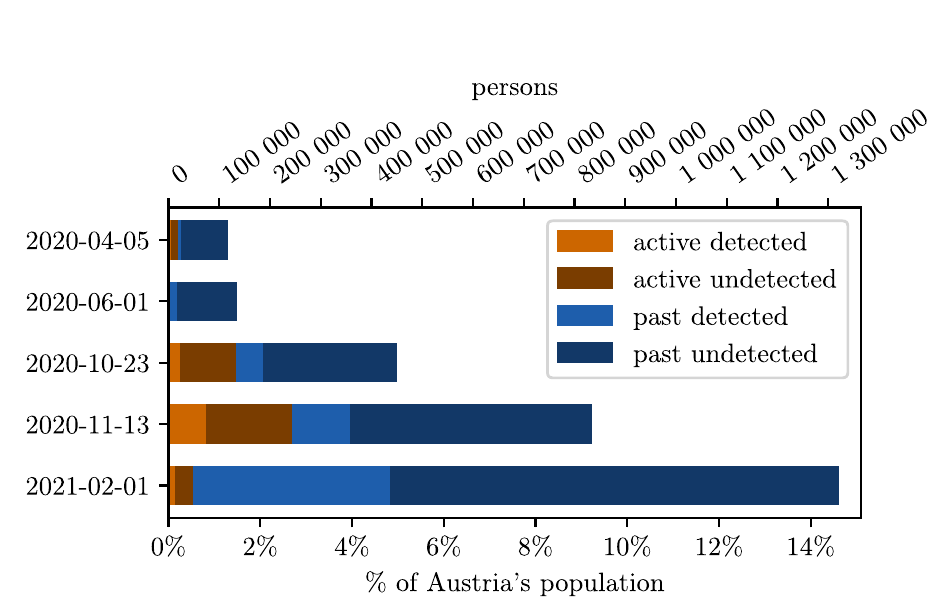
Figure 3. Active and past infections of SARS-CoV-2 for selected dates. Detected infections denote those people who have received a positive test result and are recorded in the official reporting system. The sum of active and past infections denotes the people who have been in contact with SARS-CoV-2 up to that